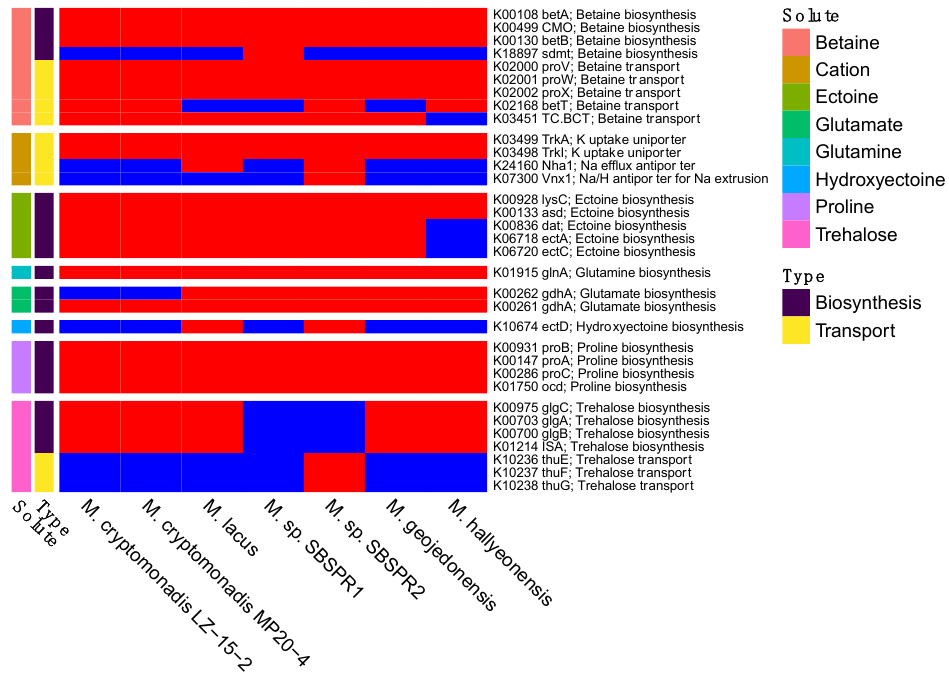
Figure 6. Presence ( red ) or absence ( blue ) of compatible solute or salt biosynthesis and transport genes, with their abbreviated names and KEGG K number assignments. Compounds include betaine, cations (K + , Na + , H + ), ectoine, glutamine, glutamate, hydroxyectoine, proline, and trehalose.